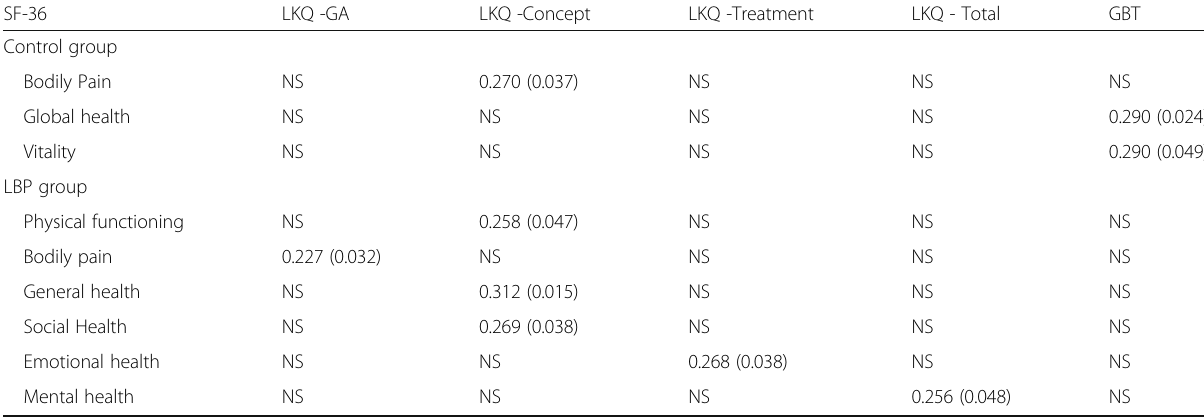
Table 5 Correlations between of SF-36 domains, the Gestural Behavior Test (GBT) and Low Back Pain Knowledge Questionnaire (LKQ) scores in the control and low back pain groups